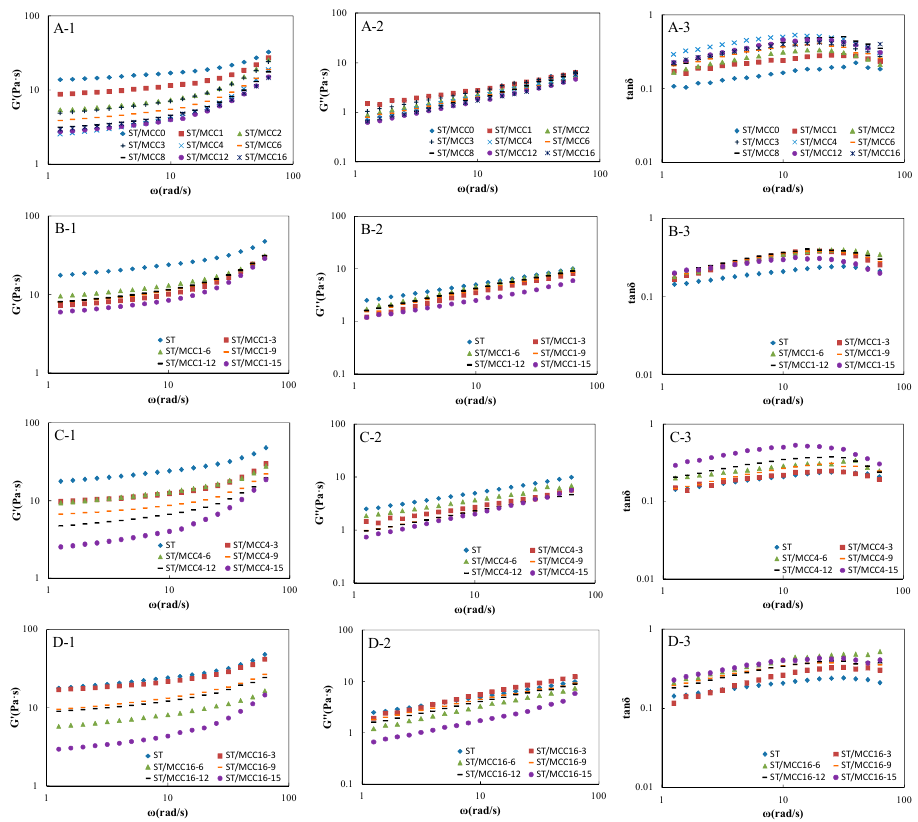
Figure 6. Dynamic modulus and loss tangent (G’, G’’ and tan δ ) versus angular frequency ( ω ) of ST/MCC suspensions with different ball milling times ( A1 – A3 ); ST/MCC1.0 h suspensions ( B1 – B3 ); ST/MCC4.0 h suspensions ( C1 – C3 ); and ST/MCC16.0 h suspensions ( D1 – D3 ) with concentrations of 15 wt % (purple circles), 12 wt % (black rectangles), 9 wt % (orange rectangles), 6 wt % (green triangles), and 3 wt % (red squares) of the total dry matter weight, and the control (blue diamonds) at 25 °C.